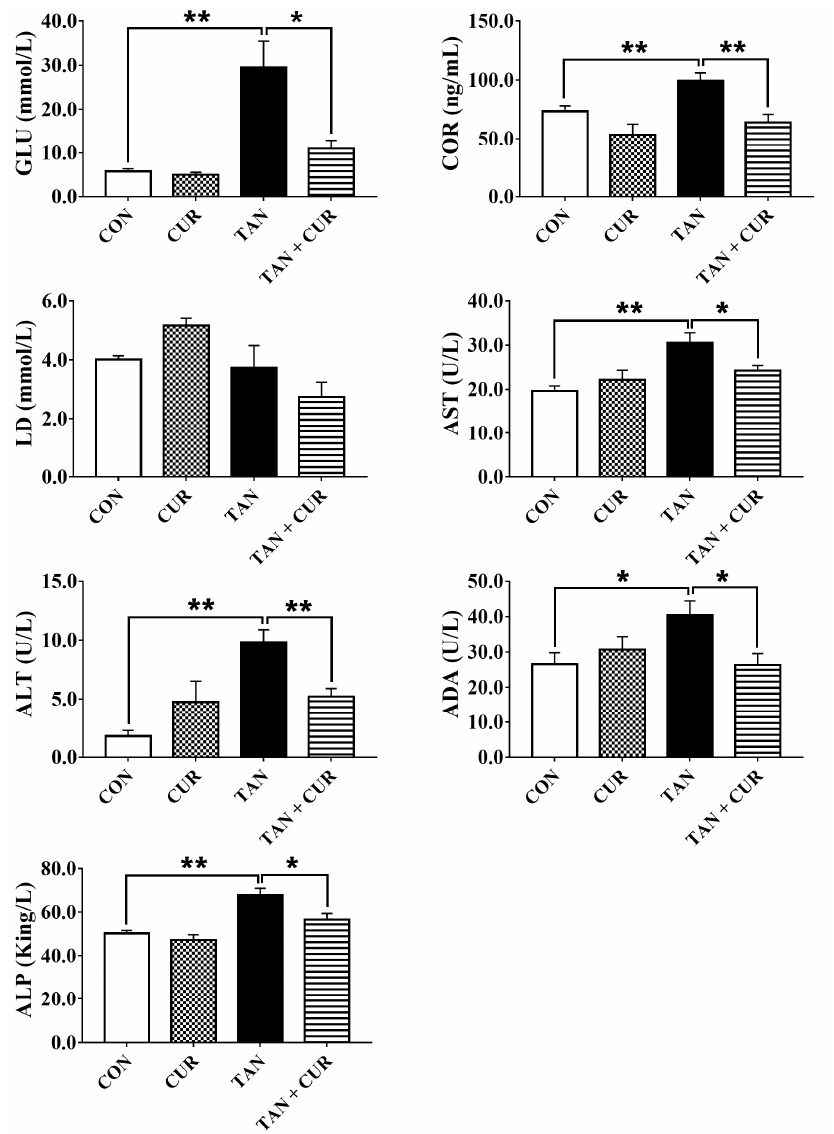
Figure 1. The changes in plasma metabolites in gibel carp after eight weeks of feeding CUR diets followed by acute ammonia stress. CON—control; CUR—curcumin; TAN—total ammonia nitro- gen; TAN + CUR—total ammonia nitrogen + curcumin. GLU—glucose; COR—cortisol; LD—lactic acid; AST—aspartate transaminase; ALT—alanine aminotransferase; ADA—adenosine deaminase; ALP—alkaline phosphatase. The values are expressed as the mean ± standard error ( n = 6). * p < 0.05; ** p < 0.01.